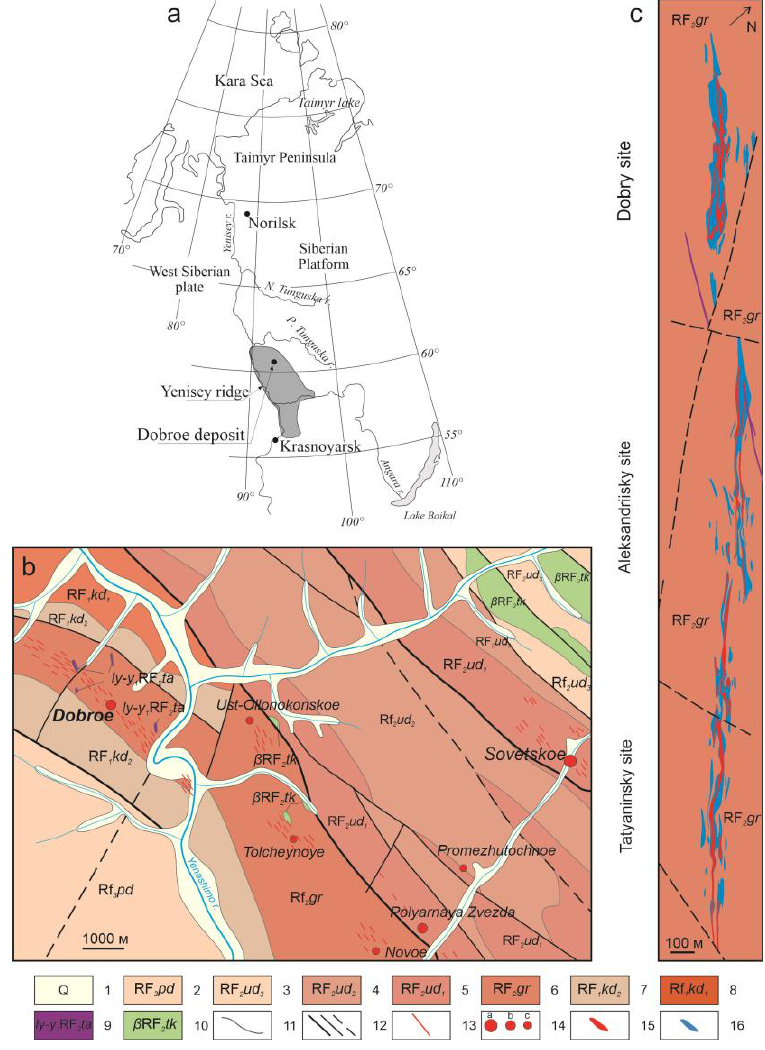
Figure 1. ( a ) Geographic location of the Dobroe gold deposit; ( b ) geological map of the Sovetsky ore cluster; ( c ) geological map of the Dobroe deposit. 1 — Quaternary sediments; 2 — Podmskaya suite (dolomites, limestones); 3 — upper Uderey subformation (argillaceous phyllitized schists); 4 — middle Uderey subformation (phyllitized shales, phyllites); 5 — lower Uderey subformation (carbonaceous phyllites); 6 — Gorbilok formation (quartz-sericite-chlorite schists); 7 — upper Corda subformation (metasiltstones, sandstones, chlorite-biotite schists); 8 — lower Corda subformation (marbles, marmorized limestones); 9 — granites of the Tatar-Ayakhta complex; 10 — dolerites of the Tokma complex; 11 — geological boundaries; 12 — tectonic disturbances: regional, proved, expected; 13 — veined silicified and sericite metasomatites; 14 — gold deposits (( a )>100 t, ( b )10 – 100 t, ( c ) < 10 t); 15 — ore bodies; 16 — mineralized zones.